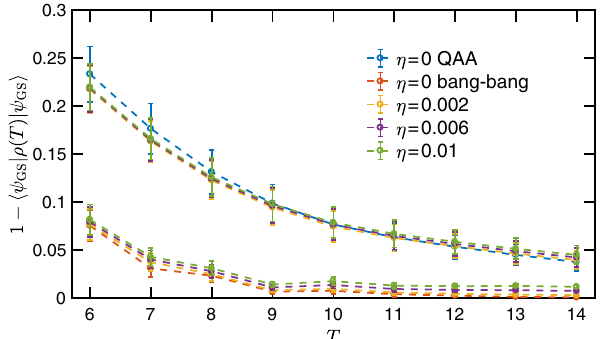
FIG. 5. Errors in the fidelity of final states evolved with the bang-bang and QAA protocols in the presence of different strengths of coupling to the environment for n ¼ 5 . The inverse temperature is chosen to be β ¼ 2 =J